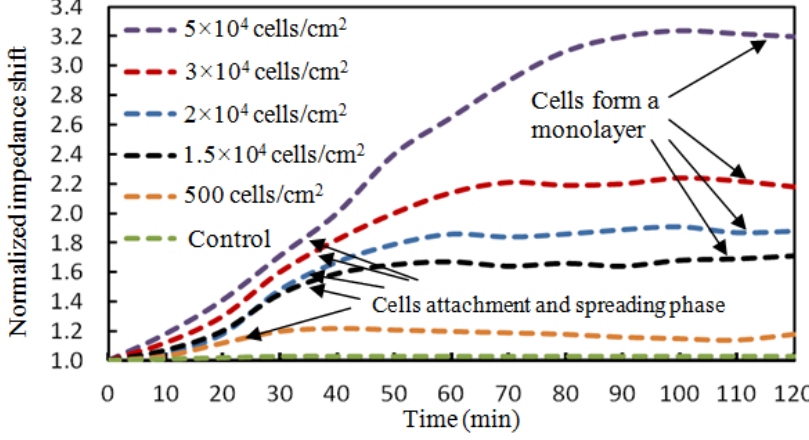
5 × 10 4 cells/cm 2 at 40 kHz.